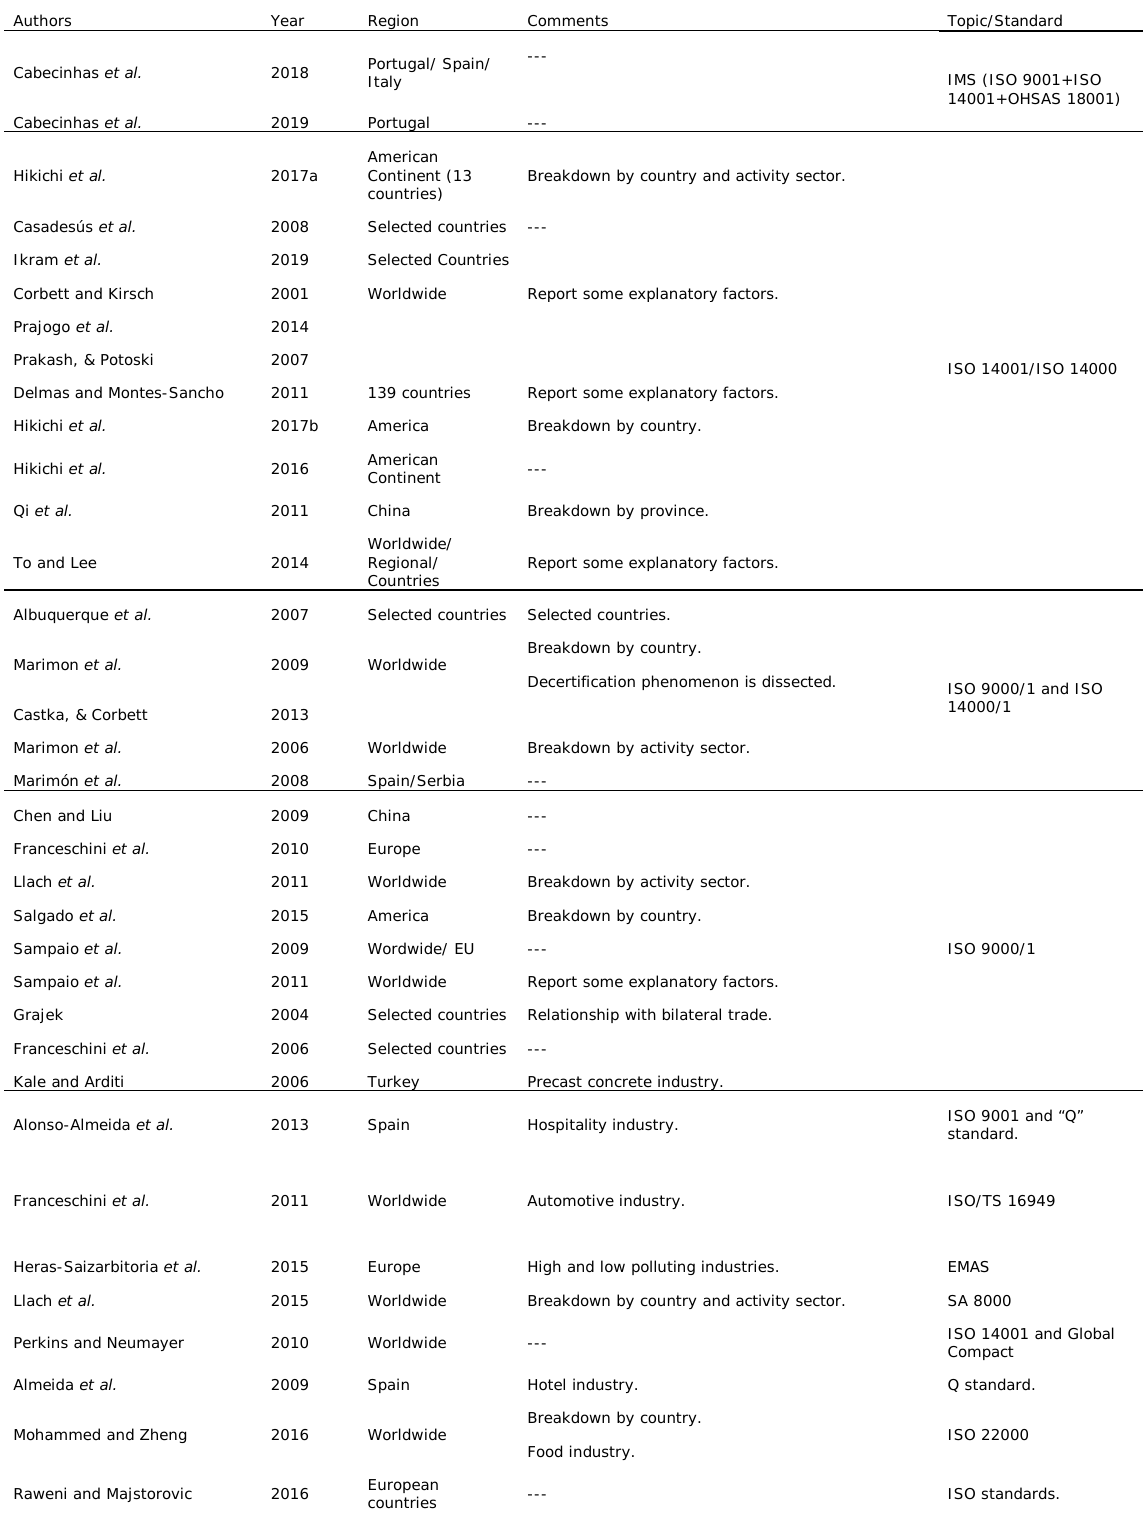
Table 1. Latest published studies in the domain of standardized MSs